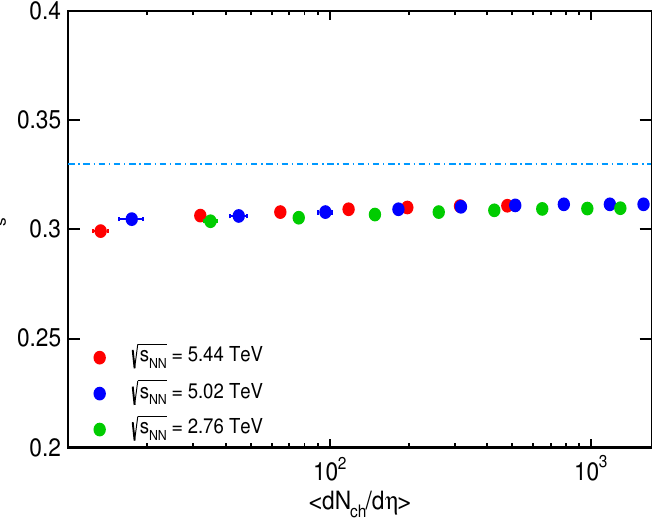
(cid:10) dN (cid:11) ch d η